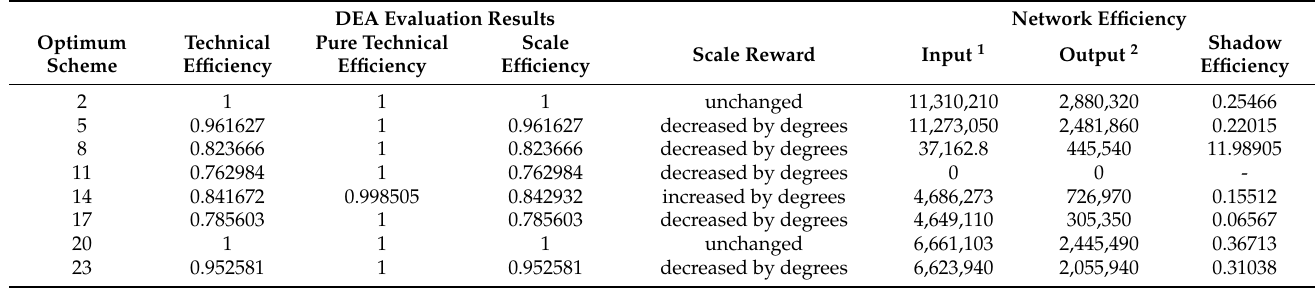
Table 10. DEA evaluation results of each program for a 10% increase in passenger flow scale. DEA Evaluation